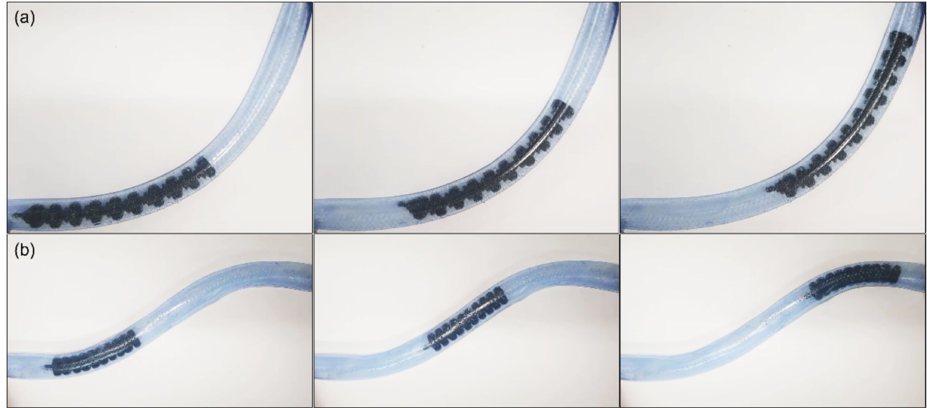
Figure 7. Demonstration of MSSR in a transparent PVC tube. Images captured according to the period of images captured in the ( a ) bent tube and ( b ) S-curved